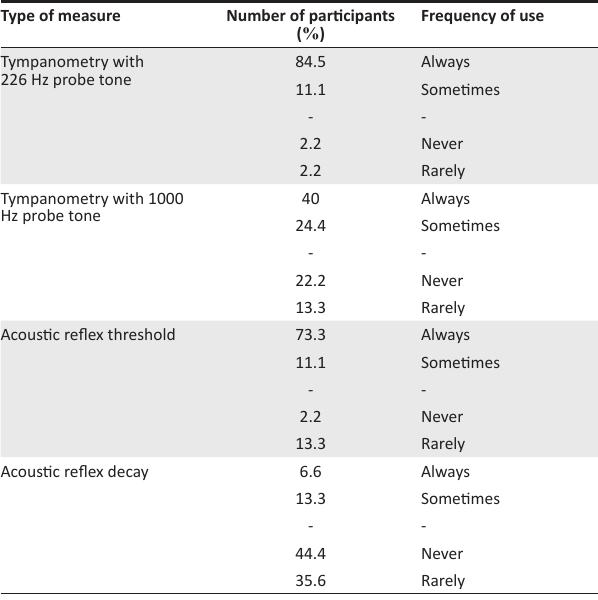
TABLE 1: Use of various acoustic immittance measures.